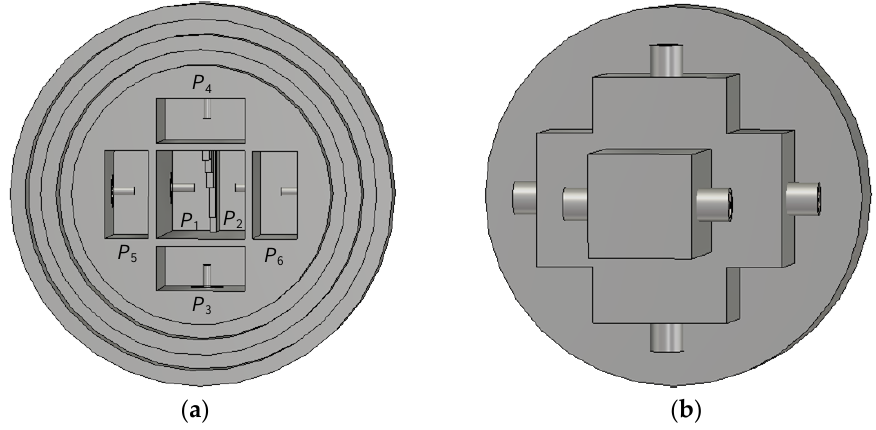
Figure 1. Structure of the proposed feed. ( a ) Front view. ( b ) Rear view.